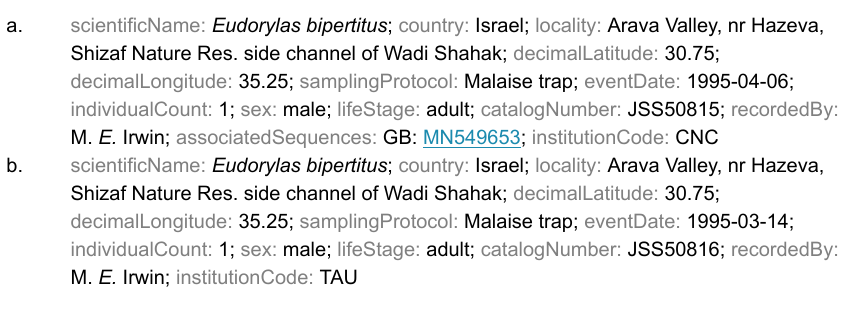
Based on DNA barcodes, Eudorylas bihamatus sp. n. is genetically most similar to E. corniculans sp. n. (5.26% pairwise divergence).